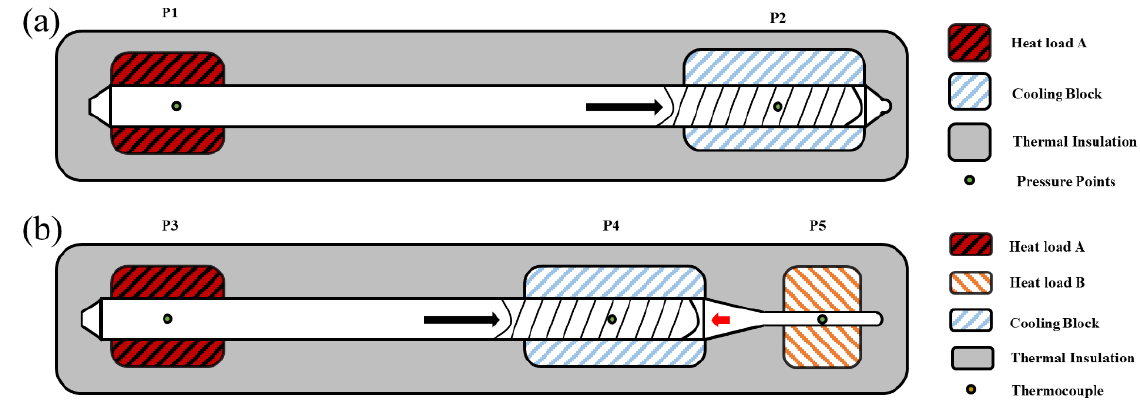
Figure 4. The distribution of steam pressure inside the heat pipes: ( a ) the distribution of steam pressure inside the heat pipes with only one single heat load; ( b ) the distribution of steam pressure inside the heat pipes with two heat loads (one heat load for the heat source, and the others served as a thermal switch).